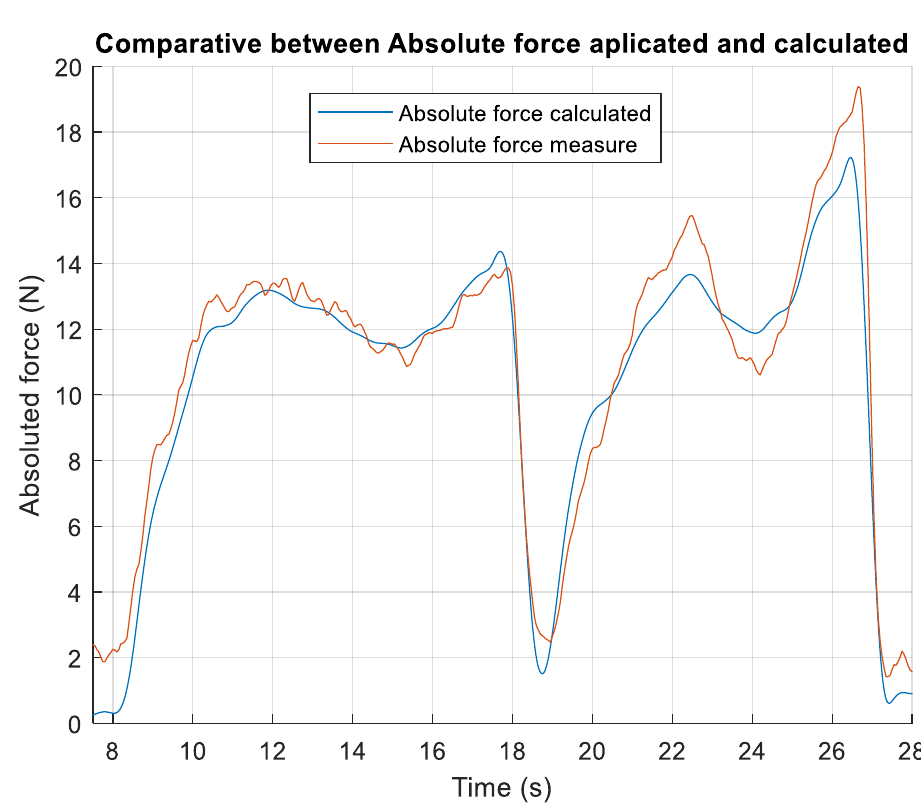
Figure 9. Comparison between applied and calculated force.